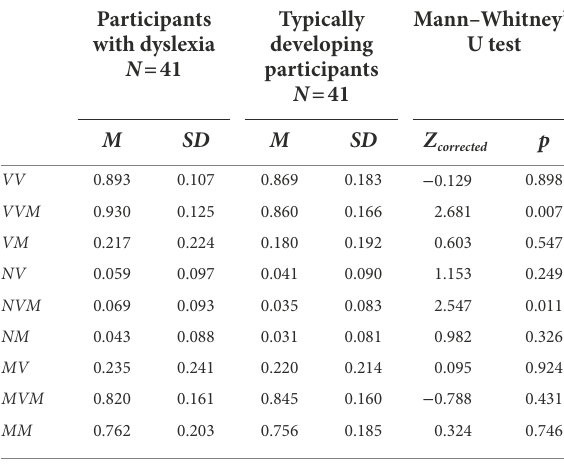
TABLE 2 Descriptive statistics for the probability of “yes” answers for different groups and test probes for the verbal material and differences test results.